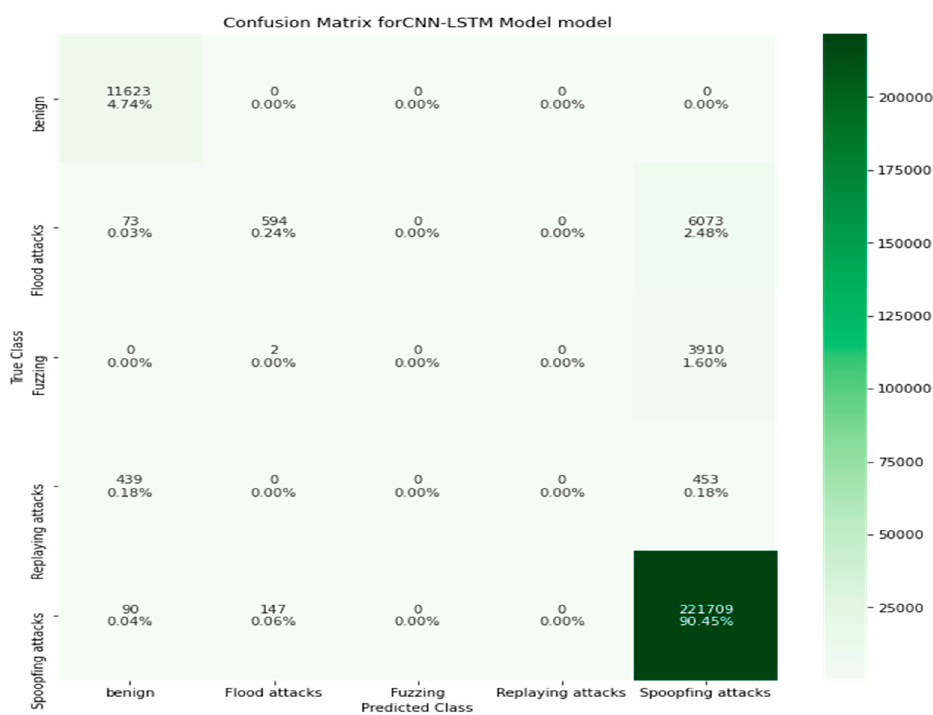
Figure 10. Confusion metrics of the CNN–LSTM model.